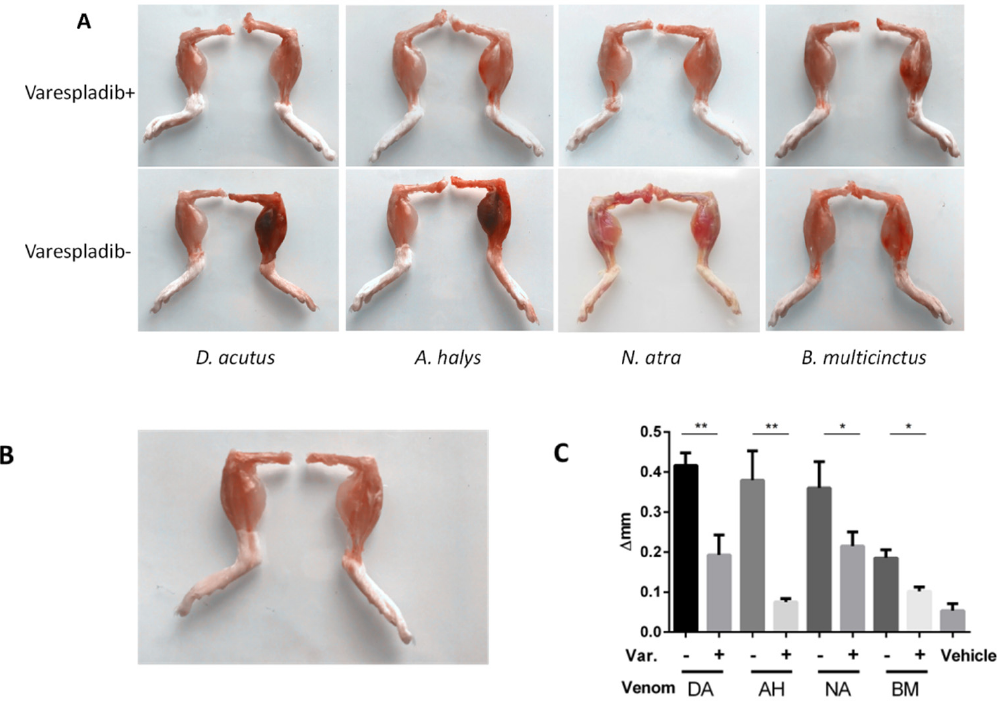
Figure 3. Myonecrosis in the gastrocnemius muscle. ( A ) Mice injected with venom derived from D. acutus and A. halys suffered from severe hemorrhage and edema in the envenomed leg. Moreover, the gastrocnemius muscles near the injection site had a deep red color and showed necrosis, swelling, and erosion of the muscular fasciae. When compared with the non-injected leg from the same mouse, the gastrocnemius of varespladib plus mice was normal in color and size; ( B ) negative control mice, injected with 20% DMSO; and ( C ) In all venom groups, the level of edema was significantly higher when compared to the corresponding varespladib inhibitory groups. ∆ mm represents the difference in the width of the left limb gastrocnemius compared to the contralateral muscle. * p < 0.05, ** p < 0.01 ( n =